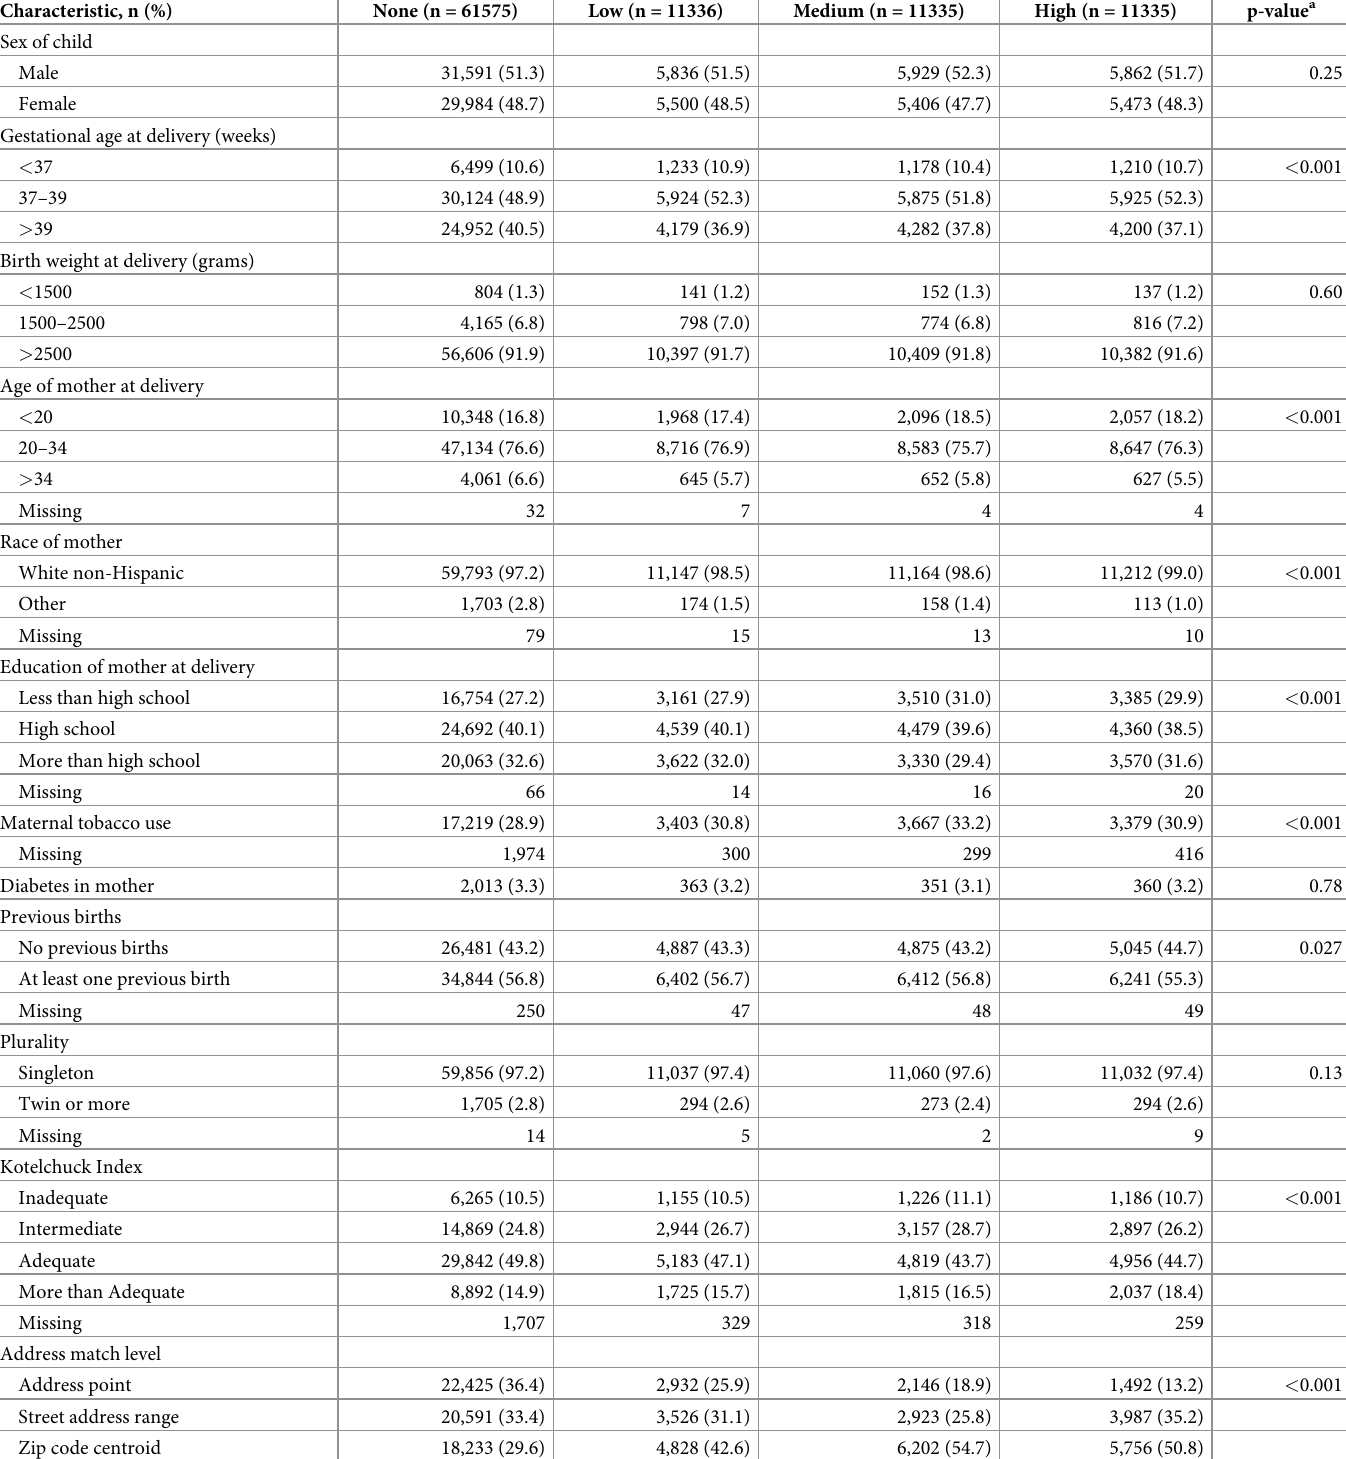
Table 1. Characteristics of Appalachian Kentucky birth records from 1997 to 2003 by level of exposure to active mountain-top removal mining within five kilome- ters of maternal residence reported at birth (N = 95,581). Characteristic, n